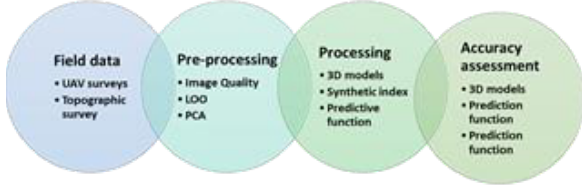
Figure 2. Operative Workflow. UAV: Unmanned Aerial Vehicles; LOO: Leave-One-Out; PCA: Principal Component